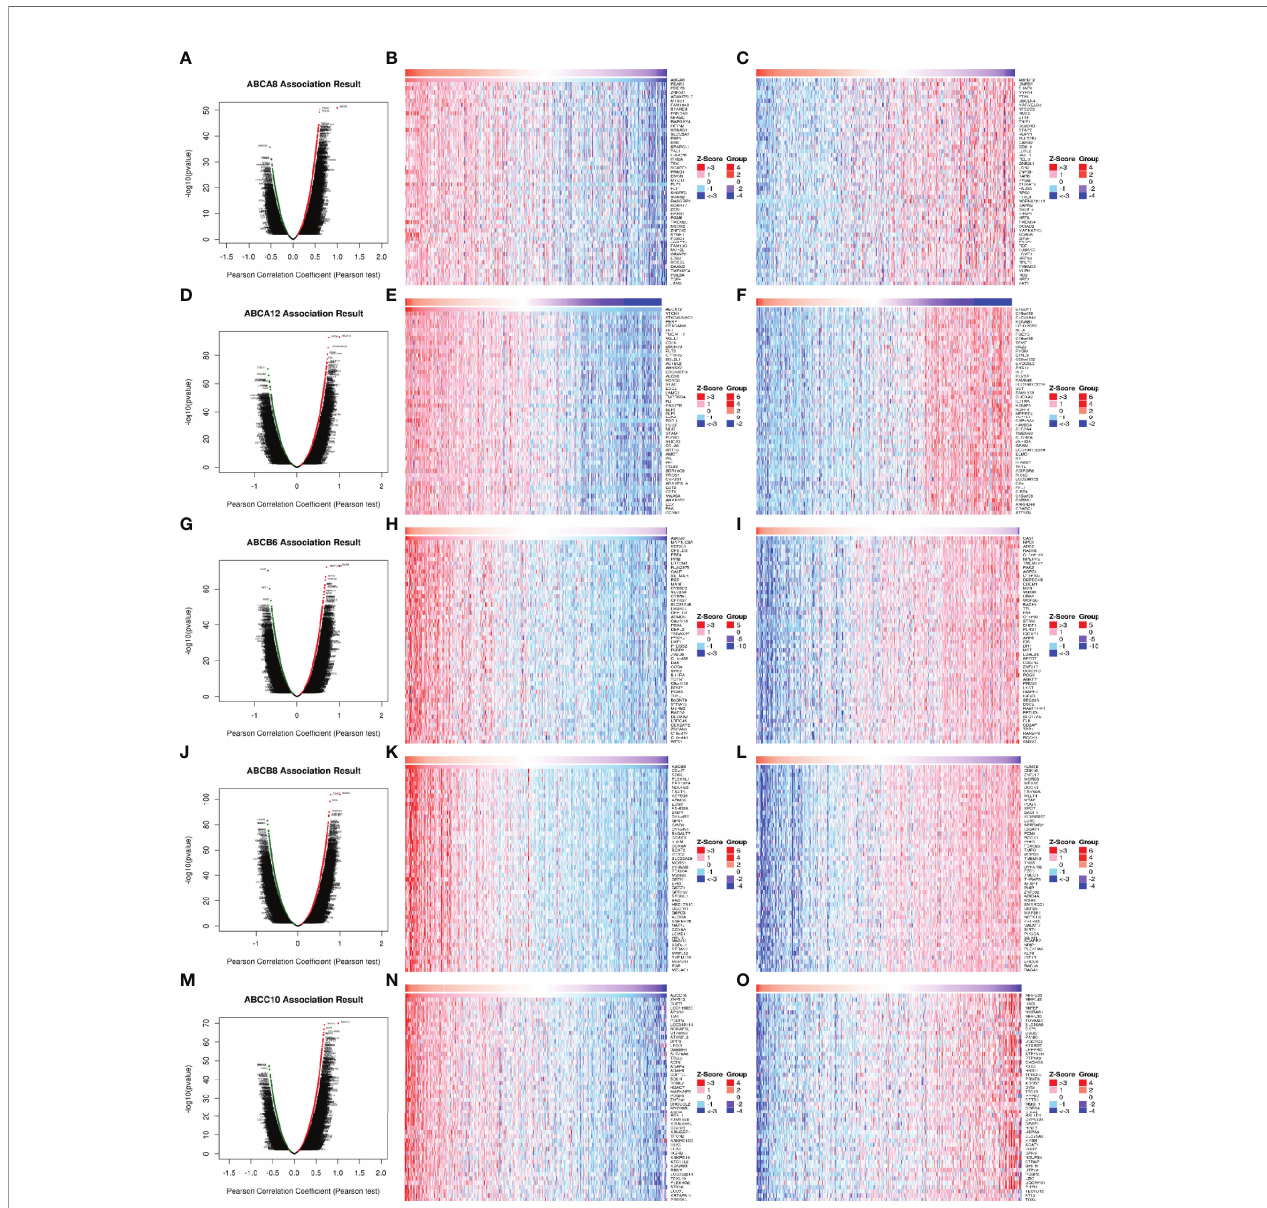
FIGURE 4 | Correlation of differentially expressed genes with fi ve hallmark ABC transporters in TC. (A, D, G, J, M) Differentially expressed genes, which were correlated with fi ve hallmark ABC transporters, were analyzed by Pearson test, and visualized in form of volcano plots. (B, E, H, K, N) The top 50 genes, which were positively correlated with fi ve hallmark ABC transporters, were visualized in form of heatmaps. (C, F, I, L, O) The top 50 genes, which were negatively correlated with fi ve hallmark ABC transporters, were also visualized in form of